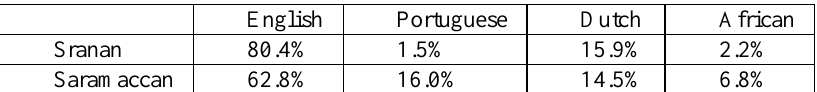
Table 1: etymological origin of Sranan and Saramaccan function words, (from Smith,